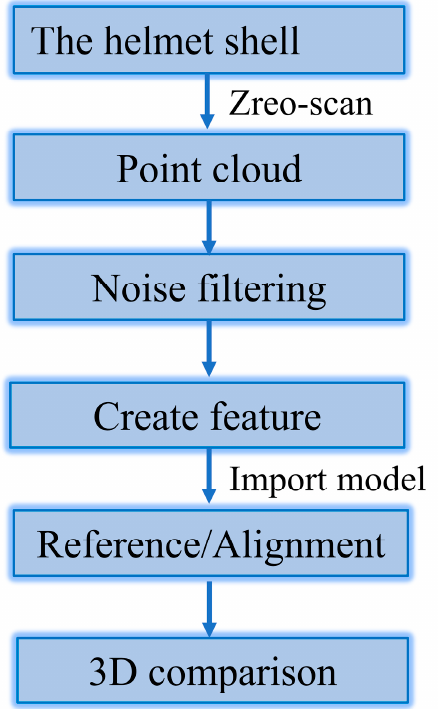
Figure 3. Work-flow of Zero-Scan 3D comparison.